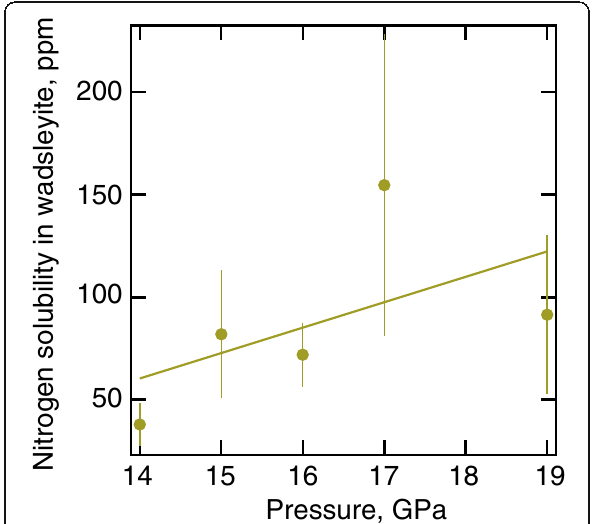
Fig. 8 Nitrogen solubility in wadsleyite [(Fe,Mg) 2 SiO 4 ] as a function of pressure (modified after Yoshioka et al. 2018)